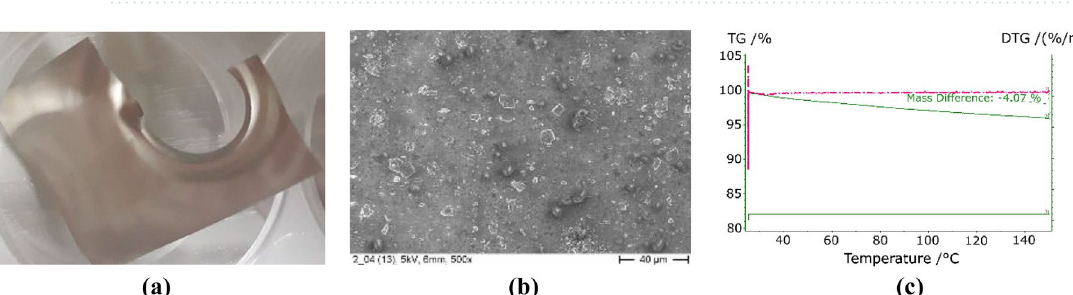
Figure 3. Comparison of the TGA analysis of Boehmite and MgSO 4 : TGA analysis of pure MgSO 4 ( a ), mixture ( b ) and after rehydration ( c ).